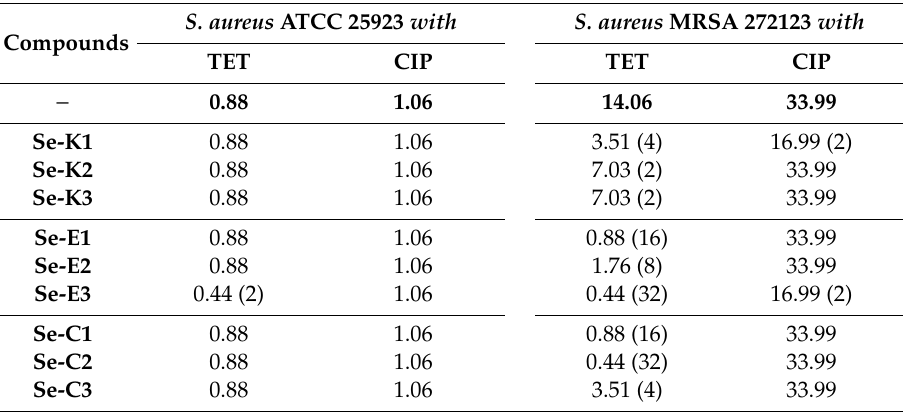
Table 2. Resistance modulating e ff ect of selenocompounds in the presence of antibiotics on S. aureus strains. The resistance modulation e ff ect of Se-compounds with ciprofloxacin (CIP) and tetracycline (TET) antibiotics on the S. aureus bacterial strains were evaluated by the checkerboard method. MIC Reduction ( µ M) In Brackets, the X-Fold Reduction of MIC Is Presented Compounds